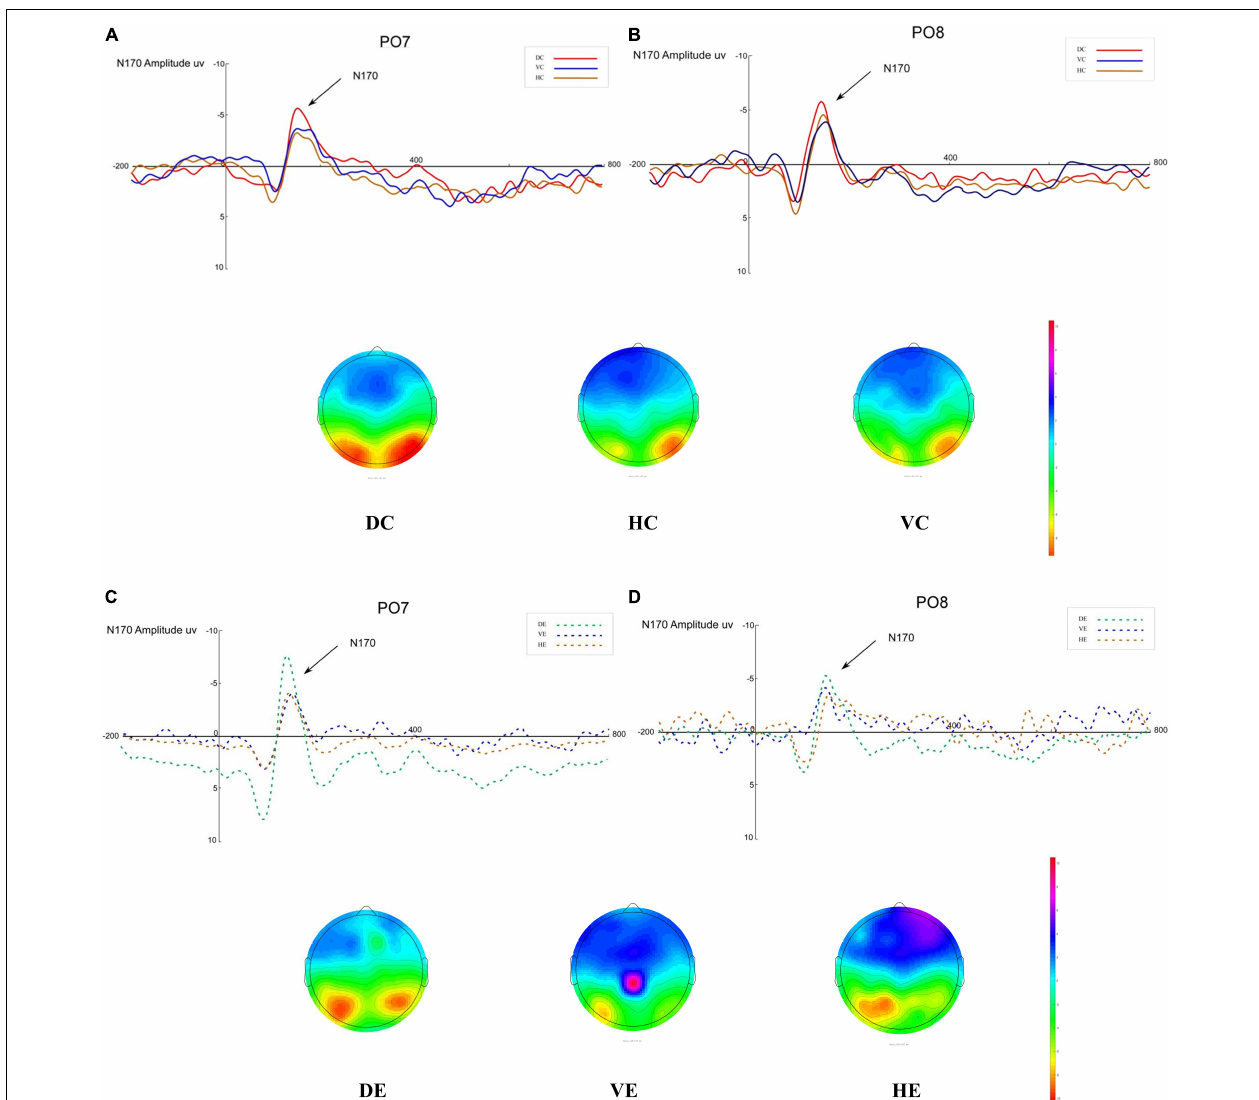
FIGURE 2 | ERP waveforms of the N170: (A) L2 Chinese PO7; (B) L2 Chinese PO8; (C) L2 English PO7; (D) L2 English PO8 parietal leads. VC: Viewing Chinese; HC: Hand Writing Chinese; VE: Viewing English; HE: Hand Writing English; DC: Drawing followed by Chinese Word Recognition; DE: Drawing followed by English Word Recognition. Topographic maps of experimental